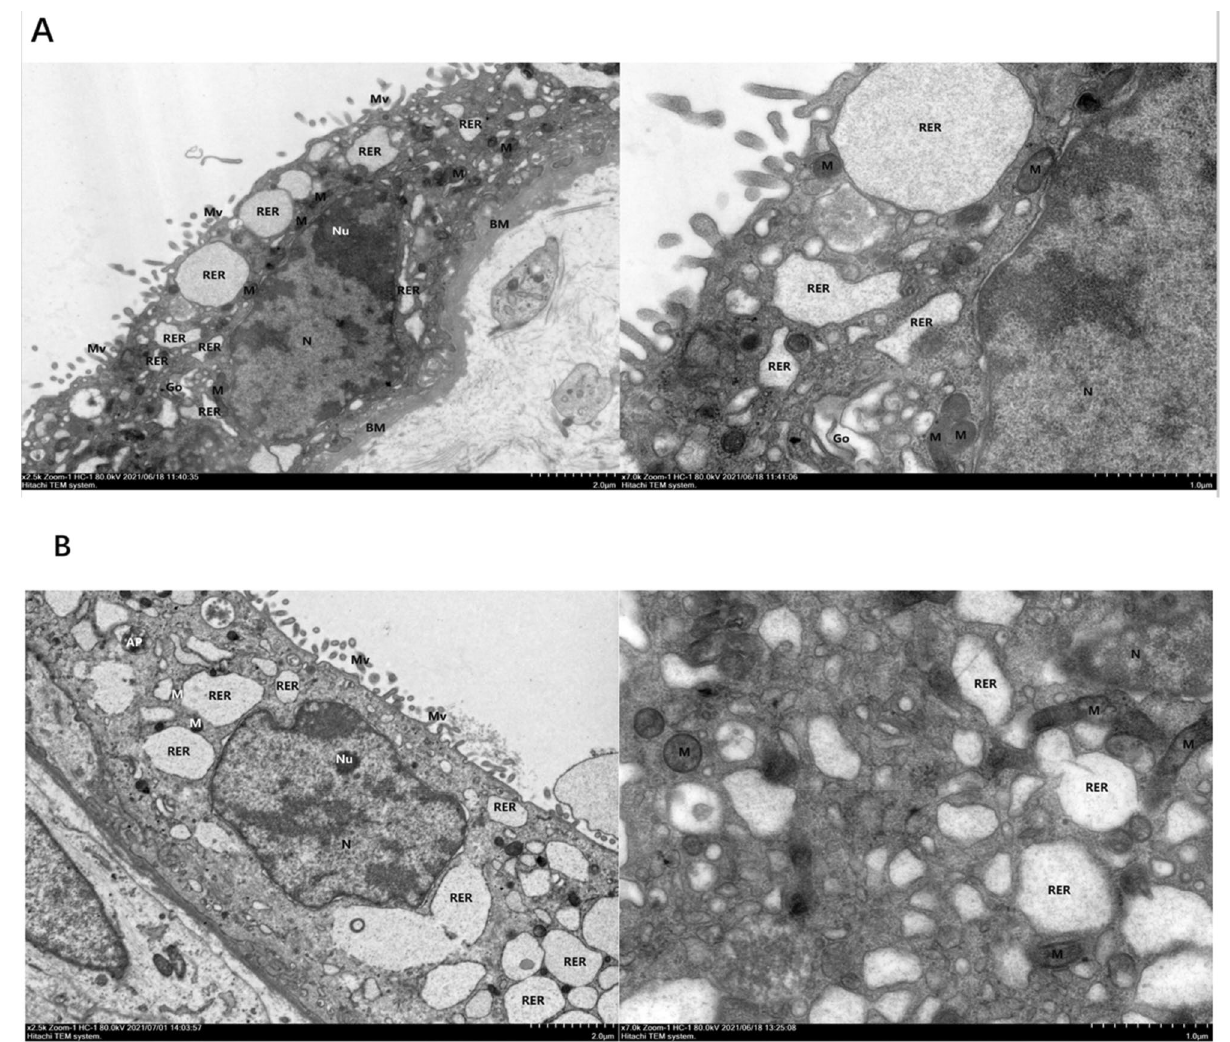
Figure 2. Morphology of placental trophoblasts from normal and preeclamptic pregnancies. ( A ) Control group, ( B ) PE group. The phenomenon of ferroptosis in group ( B ) was more serious than that in group ( A